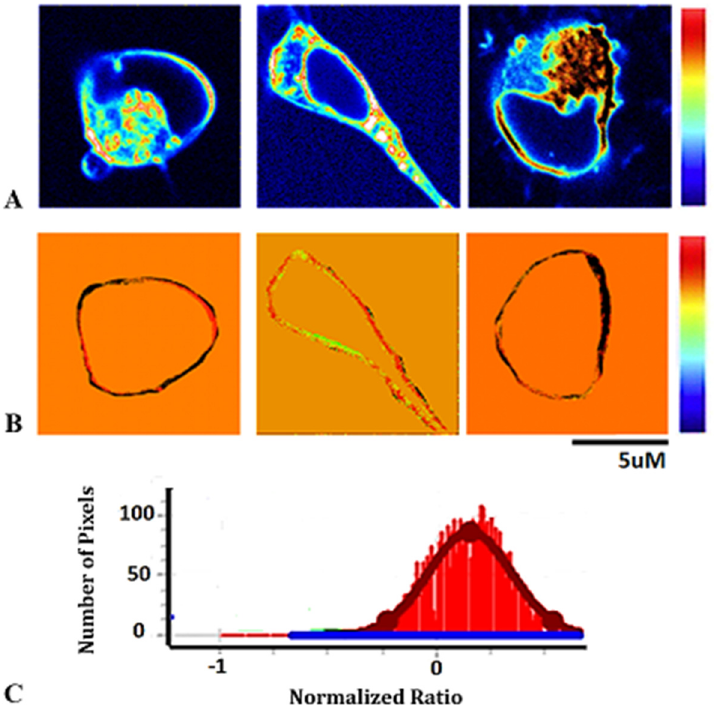
Fig 1. Laurdan GP analysis. A) Fluorescence-intensity images of three hN2 cells at 12 h observed in the blue channel (460 – 480). GP scale to pseudo color the intensity image is shown at the right. C) GP histogram from the corresponding image (membrane) in B). One Gaussian component is observed referring to the cell membrane after digital mask application. Average GP = 0.062.The width at half maximum is ~